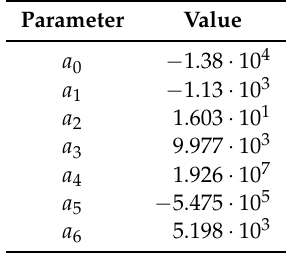
Table 2. Offline identified parameters of the current–voltage and current–power characteristics as a function of the stack current I k and the hydrogen mass flow ˙ m H